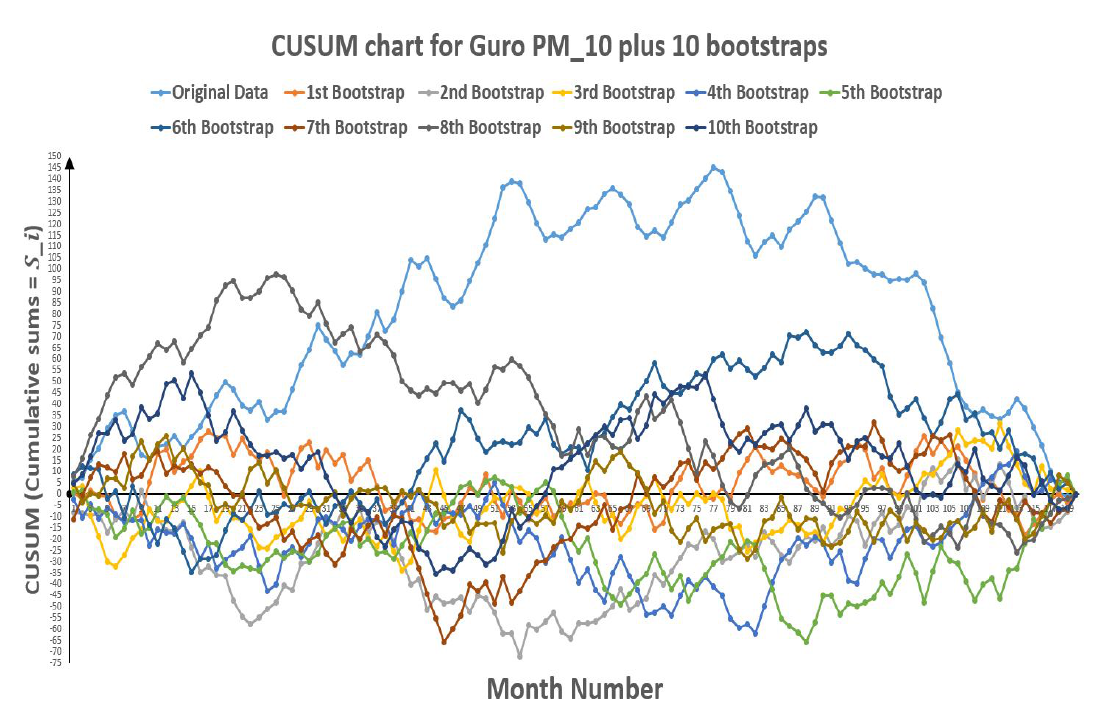
Figure 11. CUSUM chart for Guro PM 10 plus 10 bootstraps (European